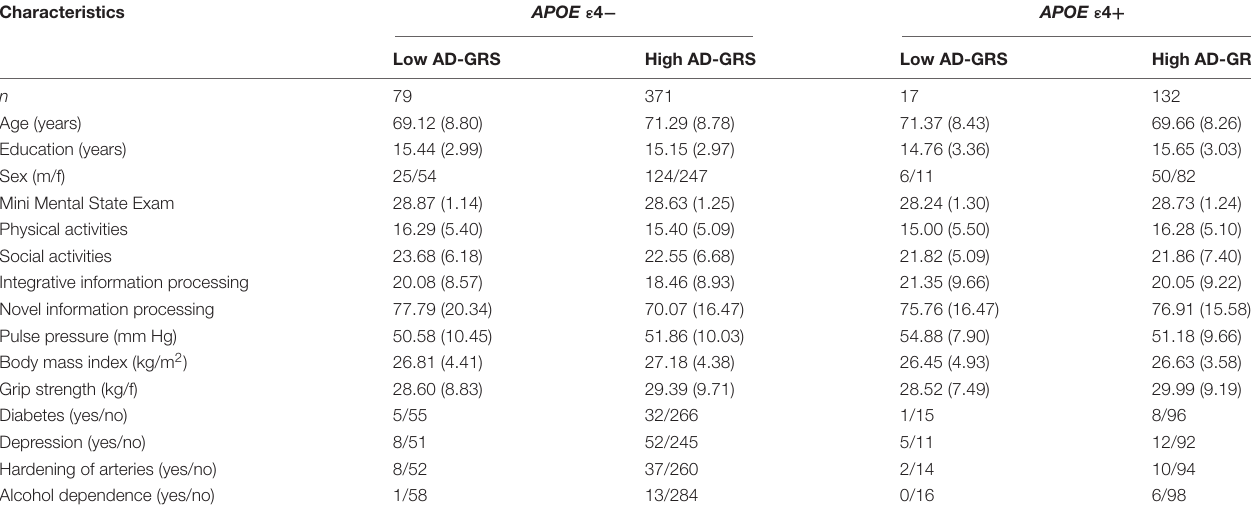
TABLE 2 | Baseline participant characteristics as stratified by Apolipoprotein E ( APOE ) genotype ( ε 4-/ ε 4 + ) and Alzheimer’s disease genetic risk score (AD-GRS; Clusterin + Complement receptor 1 + Phosphatidylinositol-binding clathrin assembly protein ).